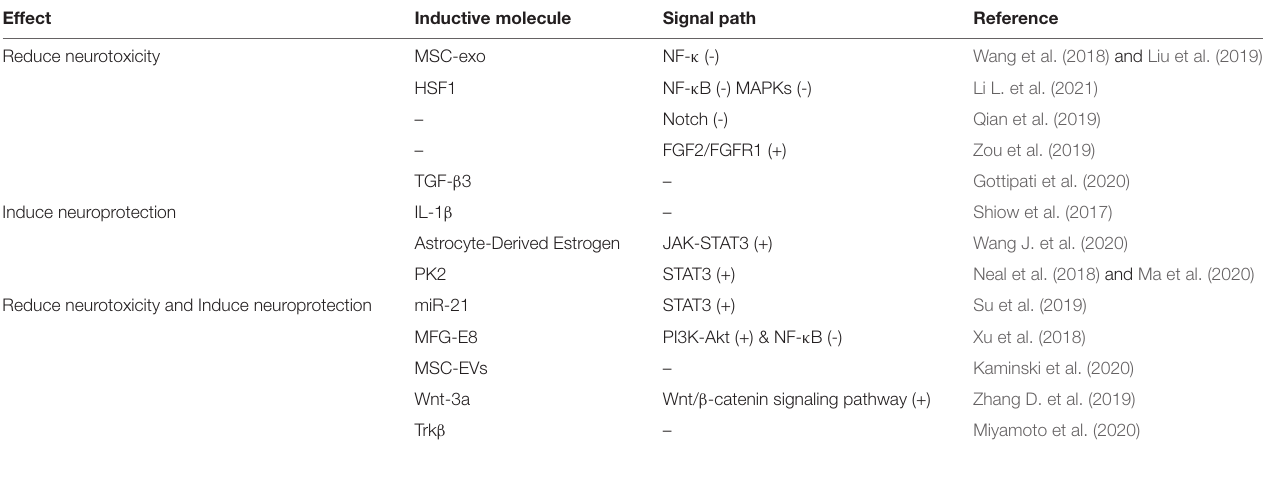
TABLE 3 | Neurotoxic astrocyte-related substances and signal